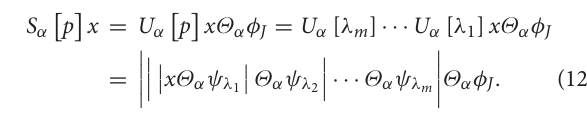
R O 1 × O 2 ×···× O K , which is then fed into the generator G to obtain the generated output tensor ˜ X α ∈ R N 1 × N 2 ×···× N K .